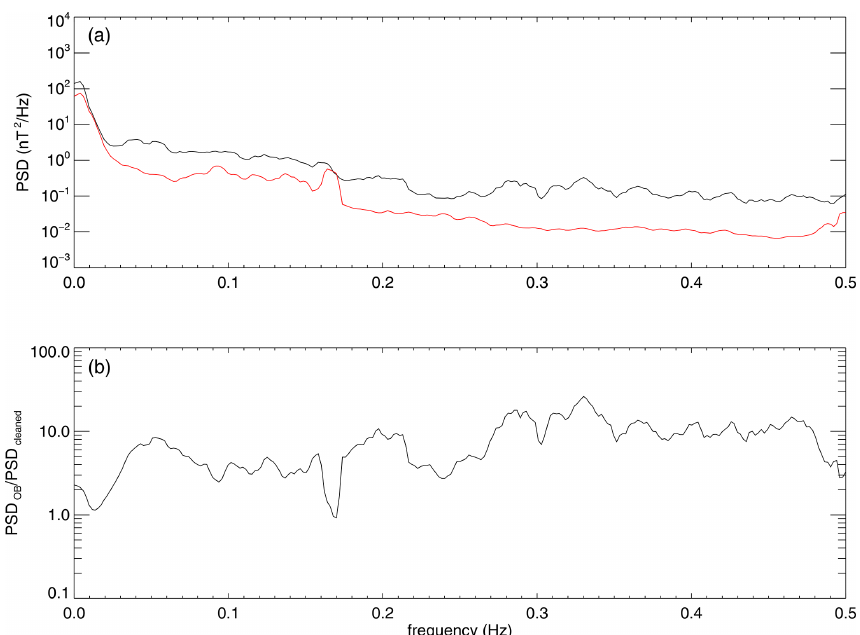
Figure 9. (a) Power spectral density of the initial FGMO measurements (black line) compared with the PSD of the cleaned data (red line). (b) The ratio between the initial and cleaned PSDs for 4 March